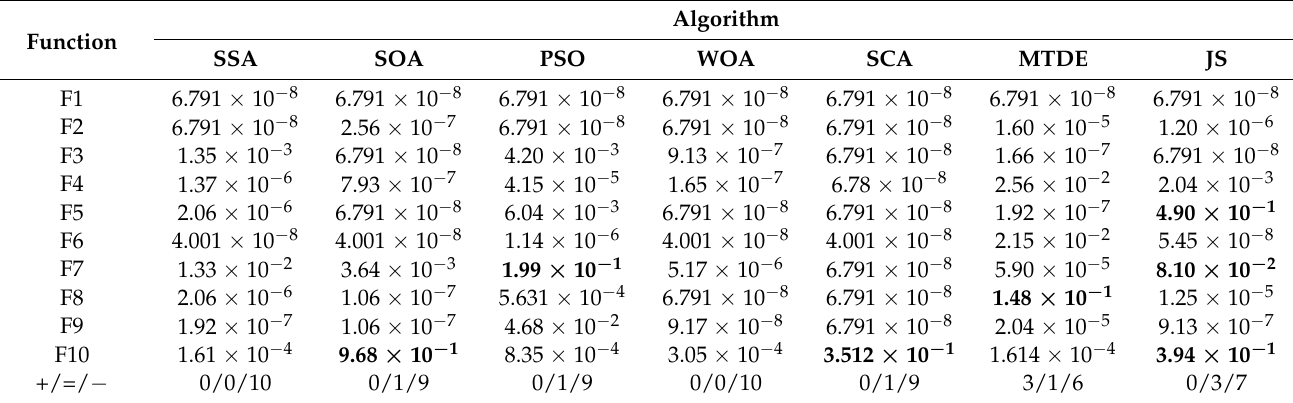
Table 5. p -value results on the CEC2019 test set with the EJS algorithm as the benchmark.